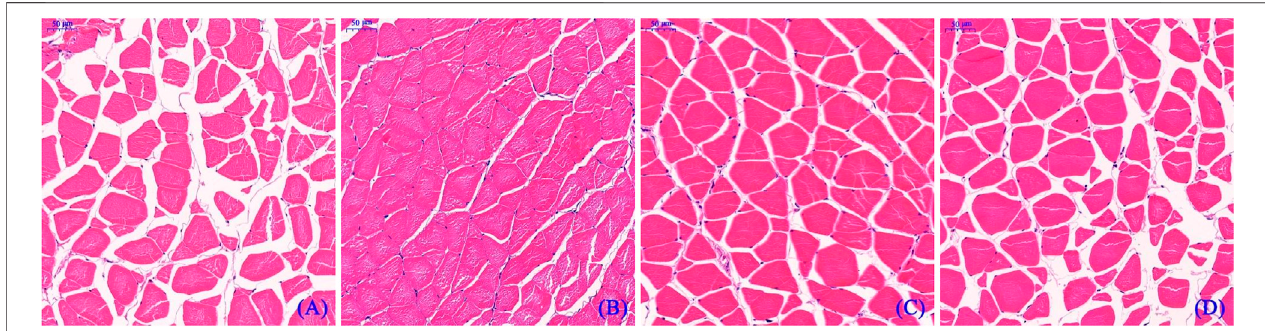
FIGURE 2 | Microstructure of dorsal muscle of ITCC in cross-section. Bars represent 50 μ ; (A – D) represent different dorsal muscle from the 0.09, 0.76, 1.14 and 1.90% of Hyp supplemental groups, respectively.